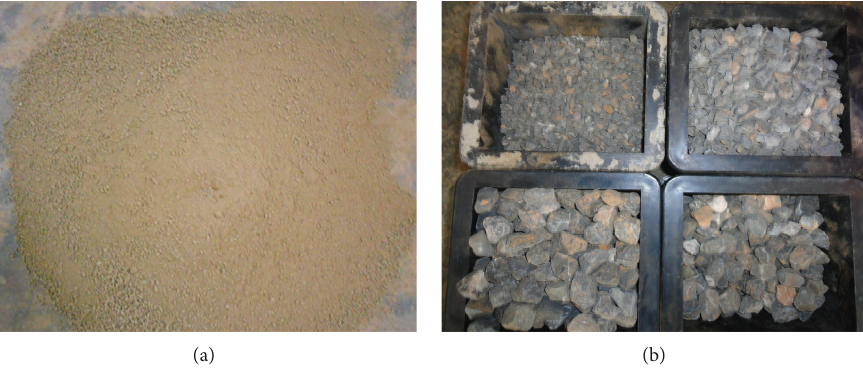
Figure 7: Soil and Gravel samples. (a) Soil sample. (b) Gravel samples.